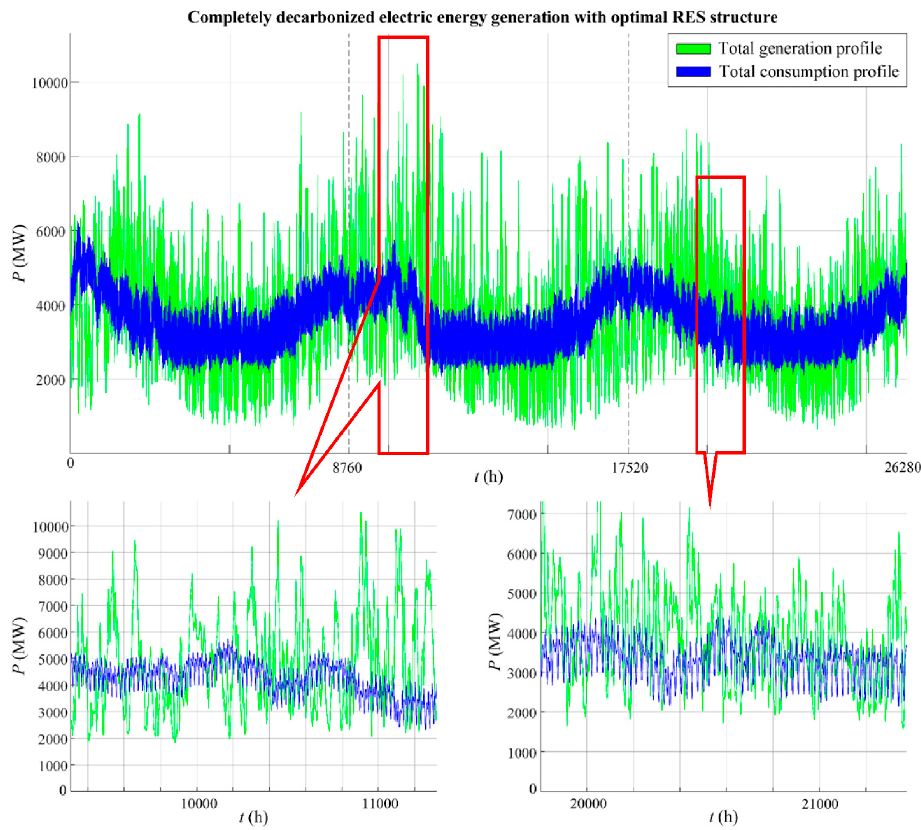
Figure 9. Total generation profile in completely decarbonized Serbian power system with optimized RES capacities.